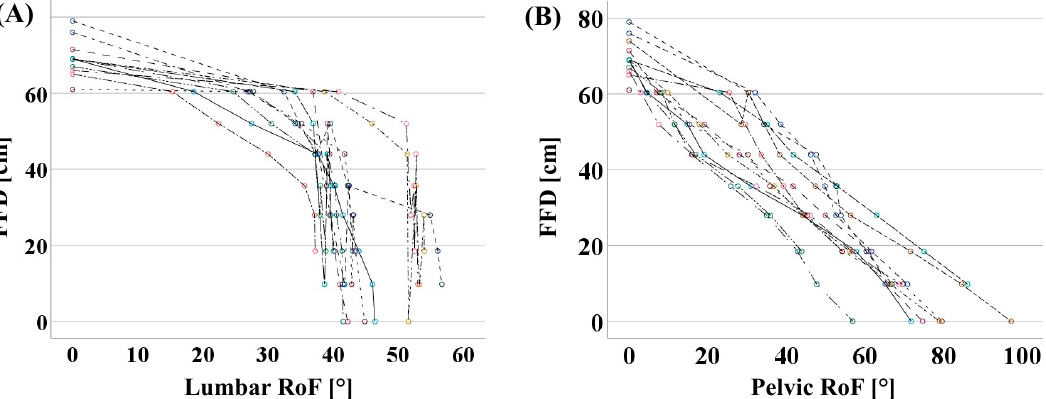
Figure 3. Relationship between gradual FFD and lumbar-RoF ( A ) and pelvic-RoF ( B ) with linear interpolation lines in the subcohort of 12 asymptomatic participants. For each participant the values were depicted in circles of one color.